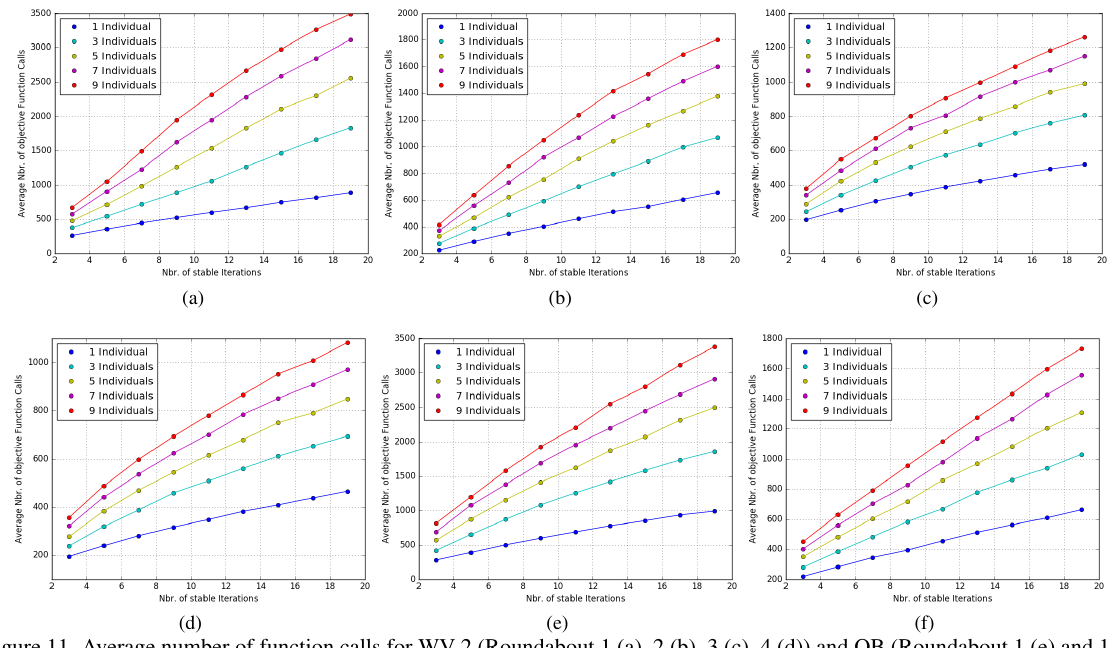
Figure 11. Average number of function calls for WV-2 (Roundabout 1 (a), 2 (b), 3 (c), 4 (d)) and QB (Roundabout 1 (e) and 1 (f))